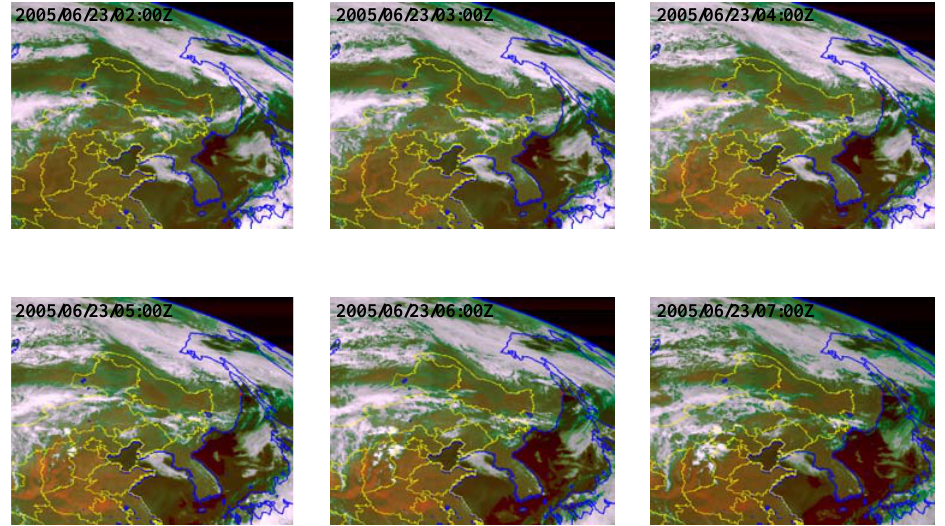
Figure 4. Forest fires hot spot monitoring hourly by using FY-2C satellite